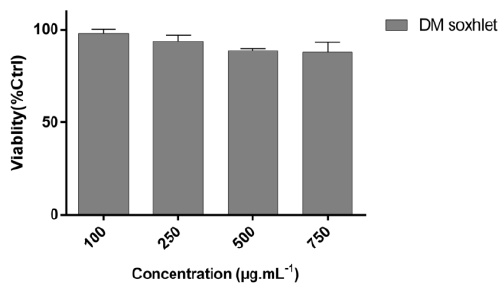
Figure 3. Minimal cytotoxic effects of dichloromethane:methanol solvent (DM soxhlet) extract against the NCM460 non-tumorigenic human colon cell line. Results by MTT are reported as the mean ± SD from three independent experiments (n = 3).